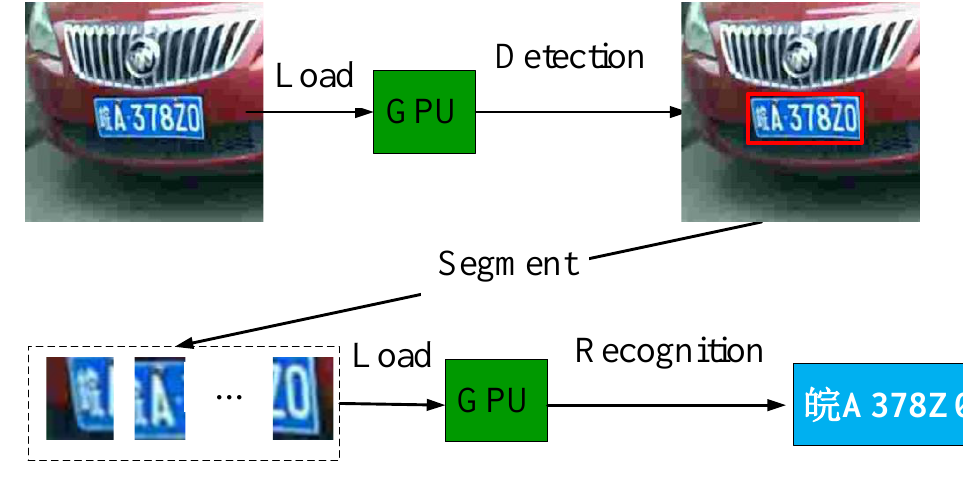
Figure 3. Traditional LP recognition